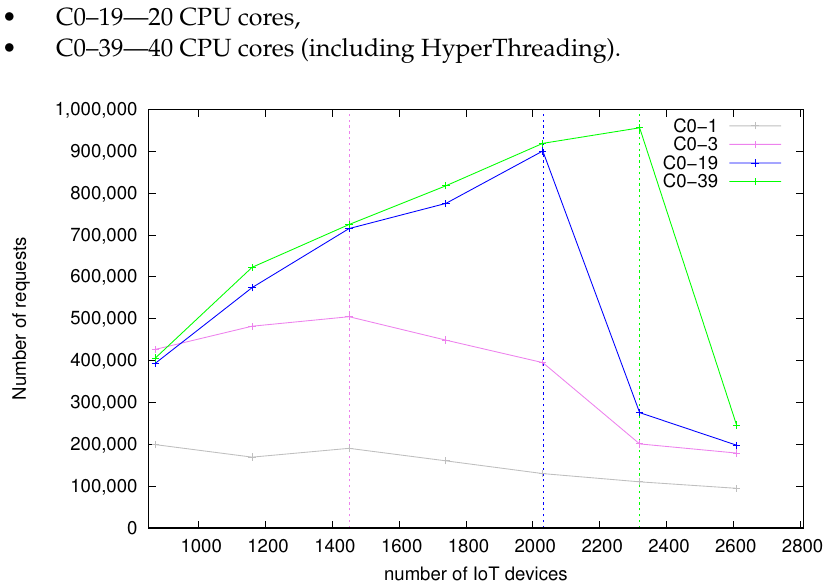
Figure 2. Number of successfully processed requests—bare-metal.